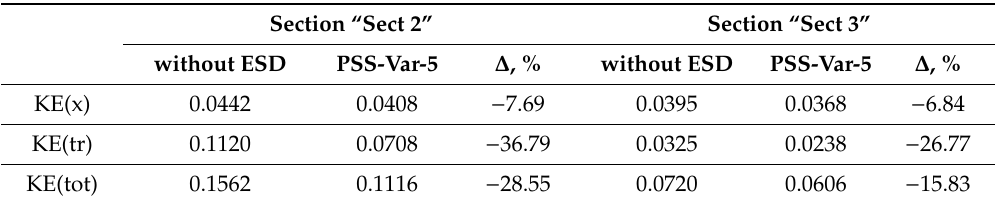
Figure 11. Distribution of the kinetic energy of axial flow on sections “Sect 2” and “Sect 3” downstream of the propeller (PSS-Var-5, full scale, Vs = 14 kn). Table 6. Averaged magnitudes of kinetic energy on the sections downstream of the propeller (“Sect 2”) and downstream of the rudder (“Sect 3”). Full scale, Vs = 14